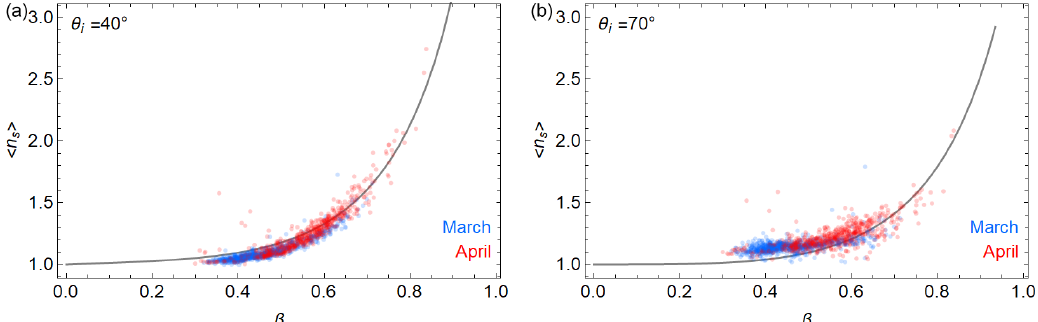
Figure 5. The average number of reflections < n s > of an individual ray hitting the surface as a function of the rms slope angle β (in radians) for two incident solar zenith angle values θ i for the snow profiles measured in the SNORTEX campaign (Manninen and Roujean, 2014; Anttila et al., 2014) in March and April 2009.